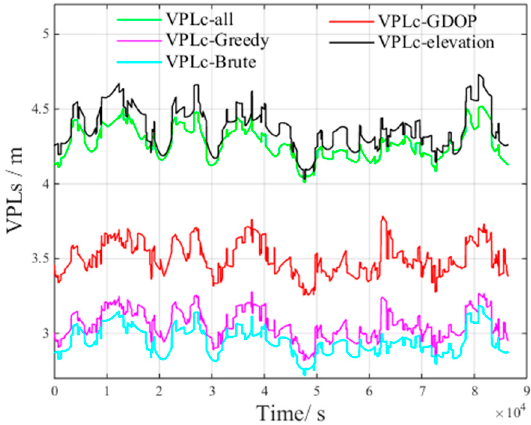
VPL Figure 17. VPL Figure 17. of different methods under non-nominal troposphere. C of different methods under non-nominal C